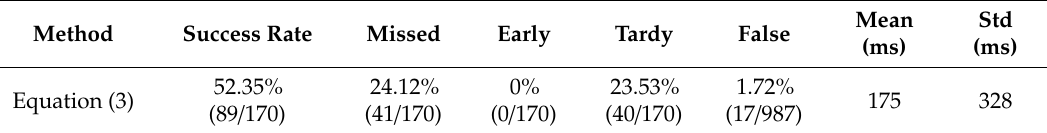
Table 3. The traditional figures of merit to assess the performance of predictors for the case of Equation (3) applied to campaigns C29–C30.